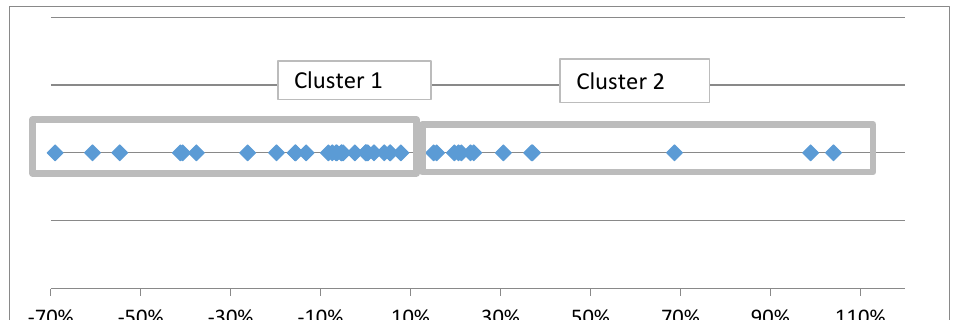
Figure A4. Percentage increase in estimated prices per kilometer of snow in 2016–2017 as compared to 2015–2016.